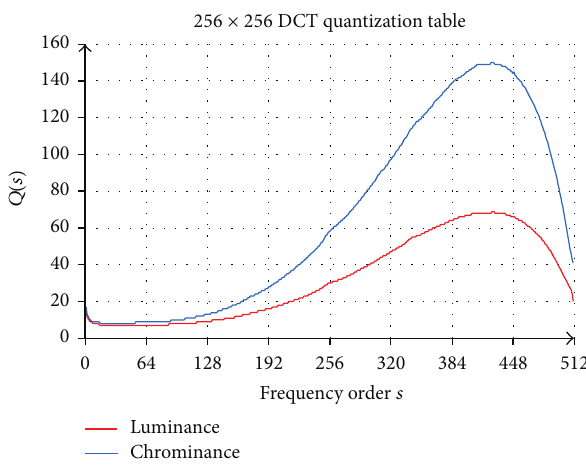
Figure 5: The 256 × 256 DCT quantization table for luminance and chrominance for image